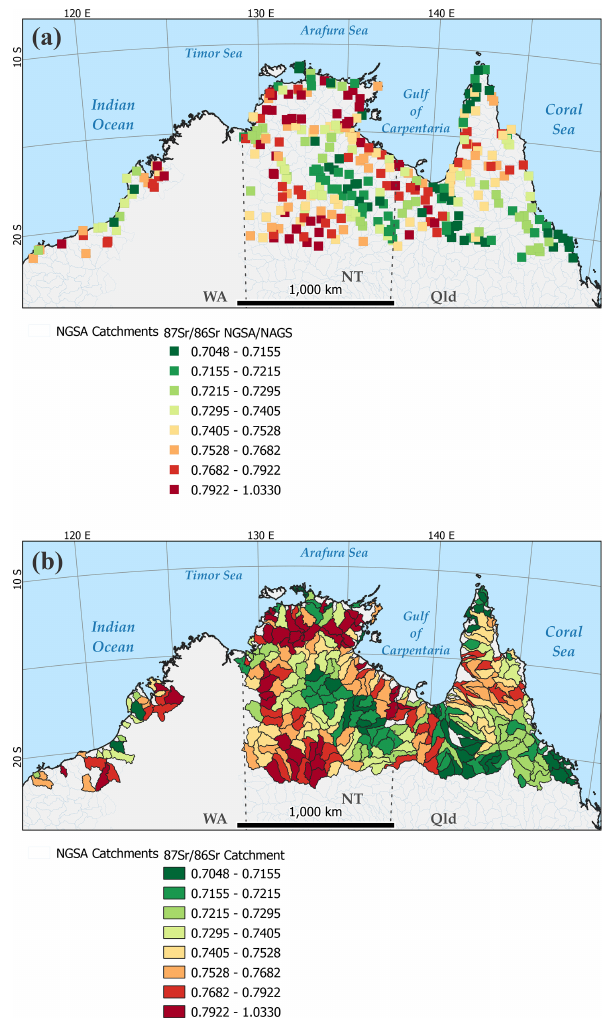
Figure 4. Strontium isoscape for the northern Australia study area with (a) data points classed by quantiles at the sampling sites and (b) as whole catchments coloured by same colour ramp. The sample medium is the < 2mm fraction of NGSA bottom outlet sediment (BOS) or equivalent (see the text for further information). Map pro- jection: Albers equal area.